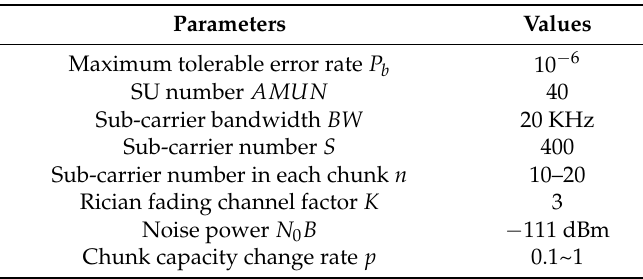
Table 1. Simulation parameters.